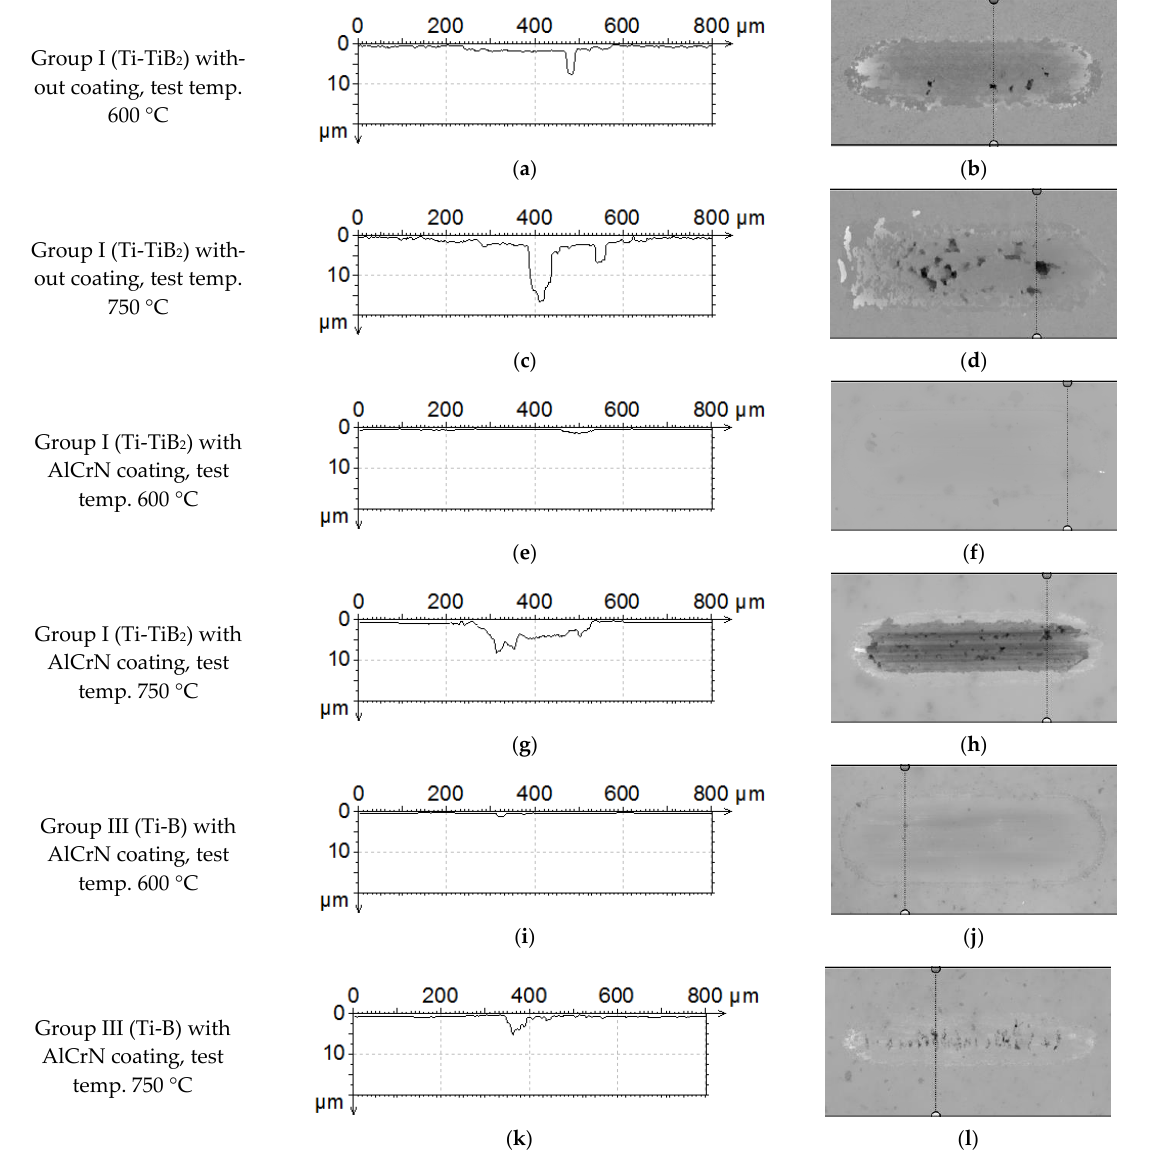
Figure 12. Wear trace profiles taken from the indicated positions: ( a ) Group I without coating, 600 °C, profile; ( b ) Group I without coating, 600 °C, position indicator; ( c ) Group I without coating, 750 °C, profile; ( d ) Group I without coating, 750 °C, position indicator; ( e ) AlCrN/Group I, 600 °C, profile; ( f ) AlCrN/Group I, 600 °C position indicator; ( g ) AlCrN/Group I, 750 °C, profile; ( h ) AlCrN/Group I, 750 °C position indicator; ( i ) AlCrN/Group III, 600 °C, profile; ( j ) AlCrN/Group III, 600 °C, position indicator; ( k ) AlCrN/Group III, 750 °C, profile; ( l ) AlCrN/Group III, 750 °C, position indicator.